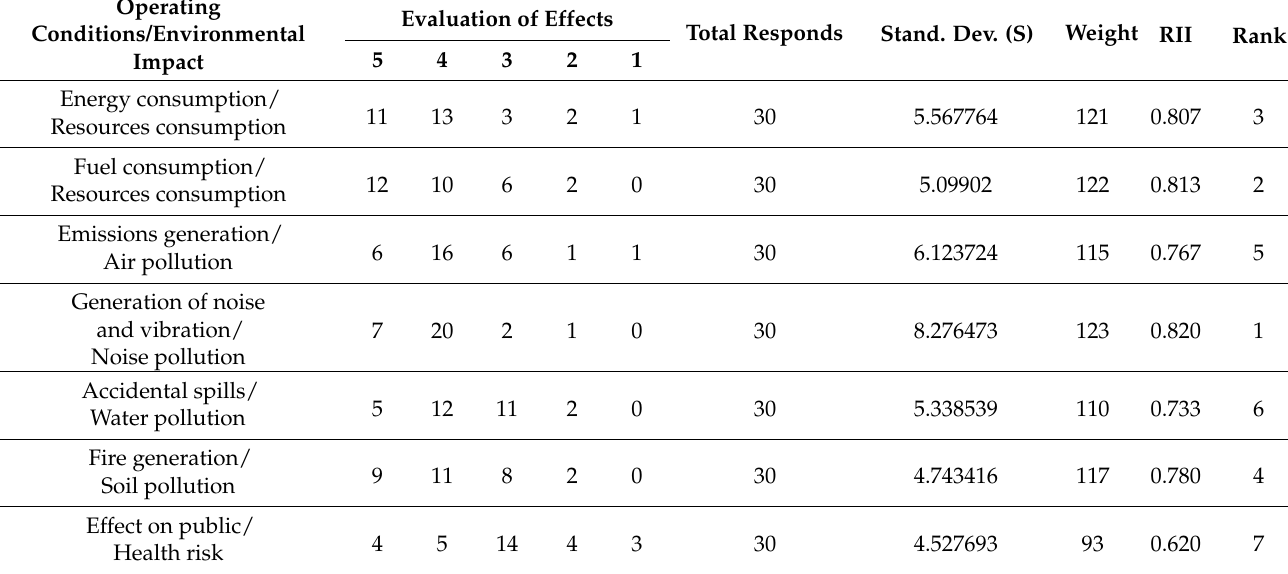
Table 3. Overall environmental impact of